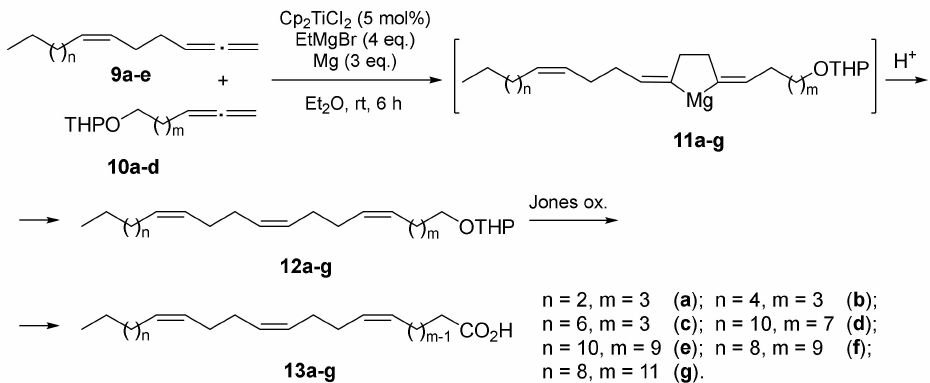
Scheme 3. ( Z , Z , Z )-Stereoselective synthesis of trienoic acids 13a – g